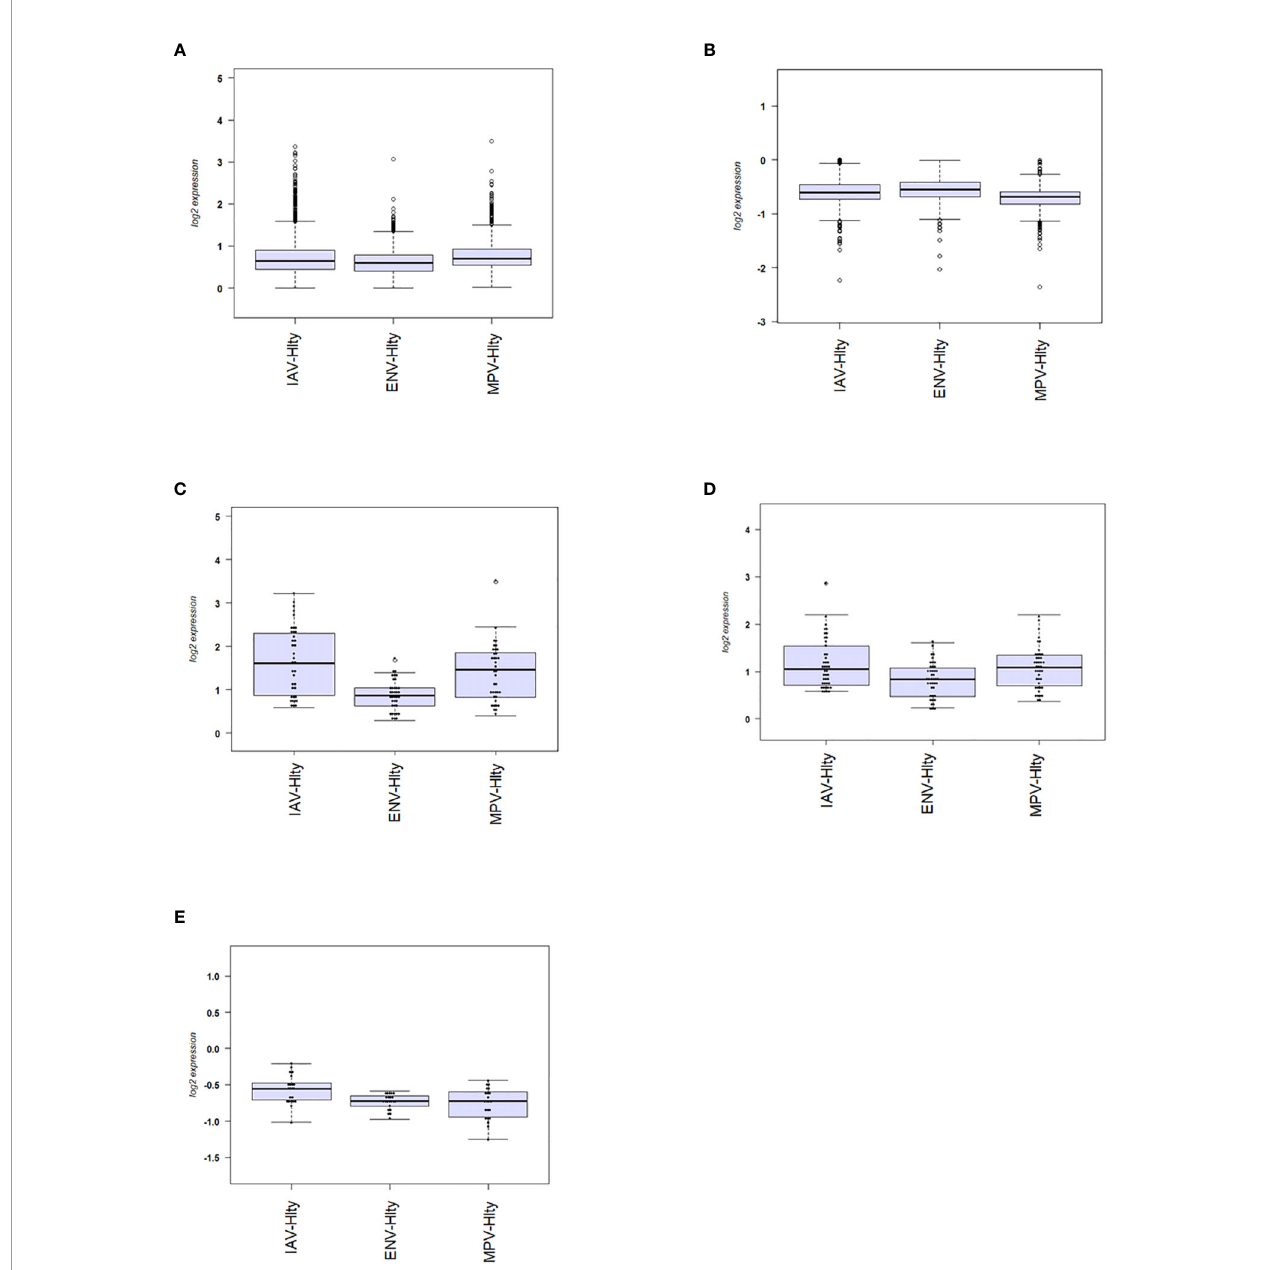
FIGURE 3 | Magnitude of responses of DEG. (A) The mean fold change difference compared to healthy controls was calculated for up-regulated DEGs induced by each virus. Differences between IAV and ENV and between MPV and ENV were statistically signi fi cant. Y-axis: difference in log2 fold expression compared to healthy controls. (B) The mean fold change difference to healthy controls was calculated for each pathogen group and all down-regulated DEGs. Differences between MPV groups and ENV and between MPV and IAV groups were statistically signi fi cant. Y-axis: difference in log 2 fold expression to healthy controls. (C) The mean fold change difference to healthy controls was calculated for each pathogen group and DEG associated with pathway ‘ Response to type I interferon ’ . The differences between IAV and MPV groups and between MPV and ENV groups were statistically signi fi cant. Y-axis: difference in log 2 fold expression compared to healthy controls. (D) The mean fold change difference to healthy controls was calculated for each pathogen group and DEG associated with pathway ‘ Cytokine secretion ’ . The differences between IAV and ENV groups between ENV and MPV groups were statistically signi fi cant. Y-axis: difference in log 2 fold expression to healthy controls. (E) The mean fold change difference to healthy controls was calculated for each pathogen group and DEG associated with pathway ‘ Regulation of T cell activation ’ . The differences between IAV groups and MPV and between IAV and ENV groups were statistically signi fi cant. Y-axis: difference in log 2 fold expression to healthy controls. IAV-Hlty: difference in normalized gene expression levels per gene between IAV infected and healthy controls; ENV-Hlty: difference in normalized gene expression levels per gene between ENV infected and healthy controls; MPV-Hlty: difference in normalized gene expression levels per gene between MPV infected and healthy